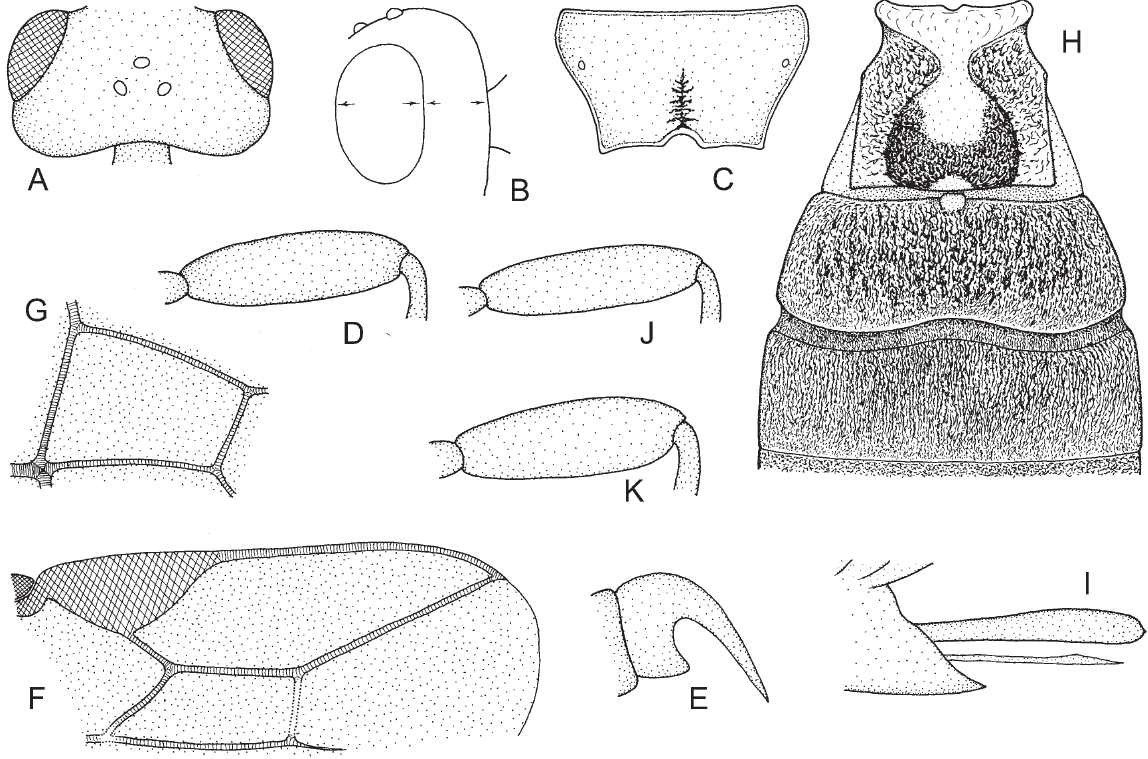
Fig. 24. Bracon ( Bracon ) nigratus Wesmael, 1838, (A-I: ♀ lectotype, J: ♀ paralectotype, ♂, K: paralectotype). A . Head in dorsal view. B . Head in lateral view. C . Propodeum. D . Hind femur. E . Claw. F . Distal part of right forewing. G . First discal cell of right forewing. H . Tergites 1-3. I . Hypopygium and ovipositor apparatus. J-K . Hind